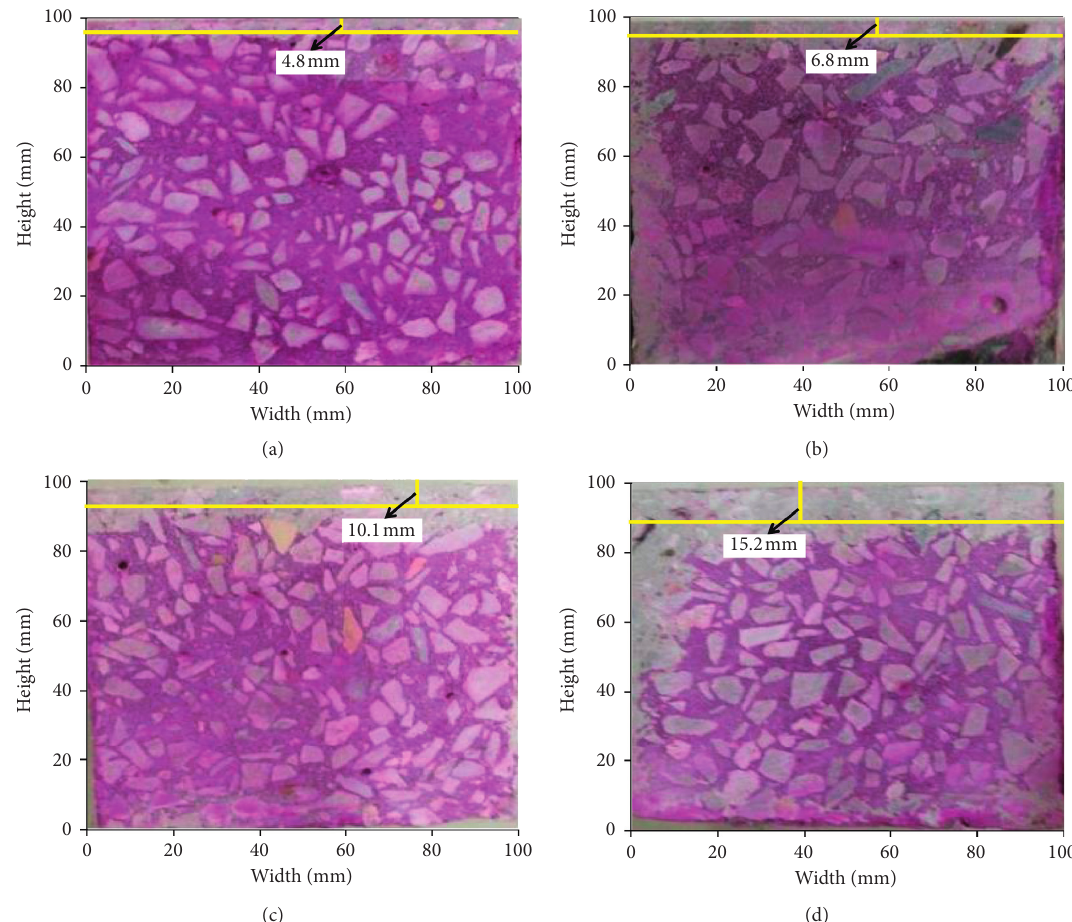
Figure 4: Carbonation depth of hybrid fiber concrete: (a) 3d carbonization depth, (b) 7 d carbonization depth, (c) 14d carbonization depth, and (d) 28d carbonization